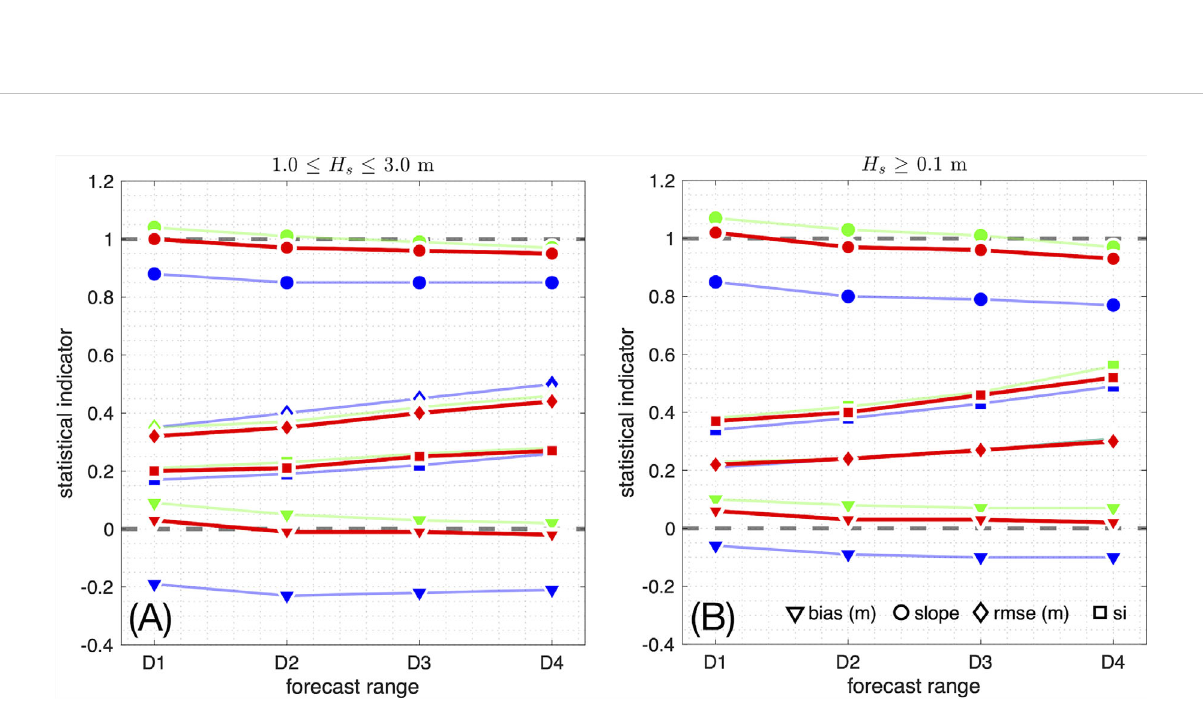
FIGURE 9 Performance of PELMO (red color) at “ Acqua Alta ” tower station in the calibration range [1.0 ≤ H s ≤ 3.0 m, (A) ] and in all conditions [ H s ≥ 0.1m, (B) ] for different forecasting ranges, compared to IFS-ECWAM (blue) and HENETUS (green): day 1 (D1, 0-23 hours from initialization), day 2 (D2, 24- 47 hours), day 3 (D3, 48-71 hours), day 4 (D4, 72-90 hours). Markers point to different statistical indicators: bias (triangle), slope (circle), rmse (diamond) and si